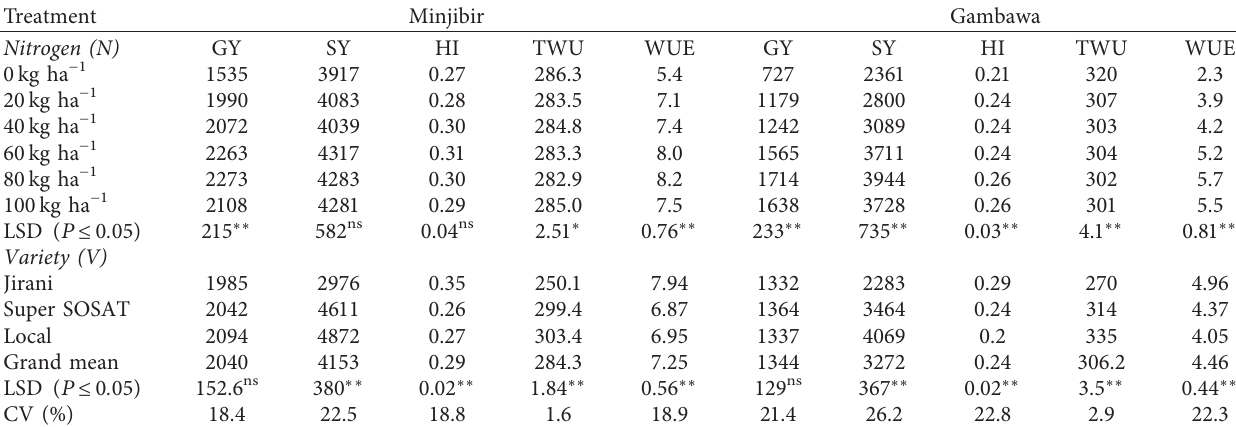
Table 3: Effect of N-fertilizer rates and pearl millet variety on grain yield (GY), stalk yield (SY), harvest index (HI), total water use (TWU), and water-use efficiency (WUE) in the semiarid zone of Nigeria. Treatment